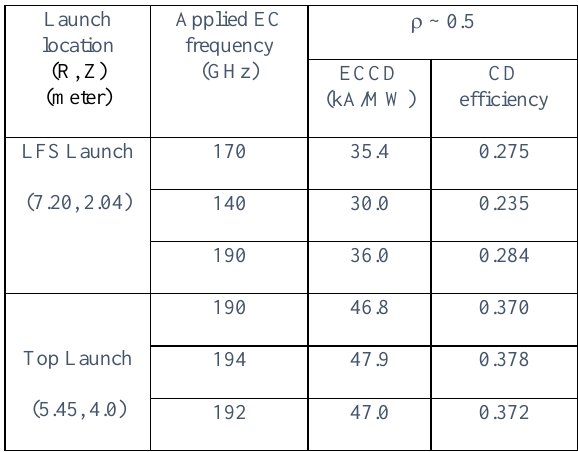
Table 1: Sample of peak ECCD efficiency from LFS vs Top